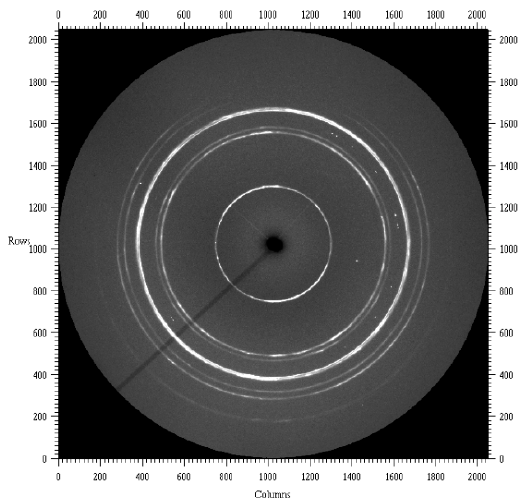
Crystals 2018 , 8 , x FOR PEER REVIEW F -3 m ), the refinement of a single peak, Cu (200) can be used to determine the pressure. For the diffraction patterns up to 21.8 GPa, a Rietveld refinement was carried out, however, due to texture in the diffraction peaks beyond this pressure, only a profile refinement was carried out above 21.8 GPa. This is sufficient to obtain the correct lattice parameters and cell volume. Figure 4. Image of the powder diffraction data of liCrO 2 collected at 7.3 GPa on CCD detector. On increasing the pressure, there are no qualitative changes observed in the diffraction patterns. Only shifting of all the peaks to higher angles is found, which is caused by the lattice compression. This evolution of XRD patterns continues until the highest pressure of 41.2 GPa is reached in the present measurements. Similar to CuAlO 2 and CuGaO 2 delaffosites [30,49], in LiCrO 2 also the intensity of the (00k) Bragg peaks and width of the reflections are affected by pressure.